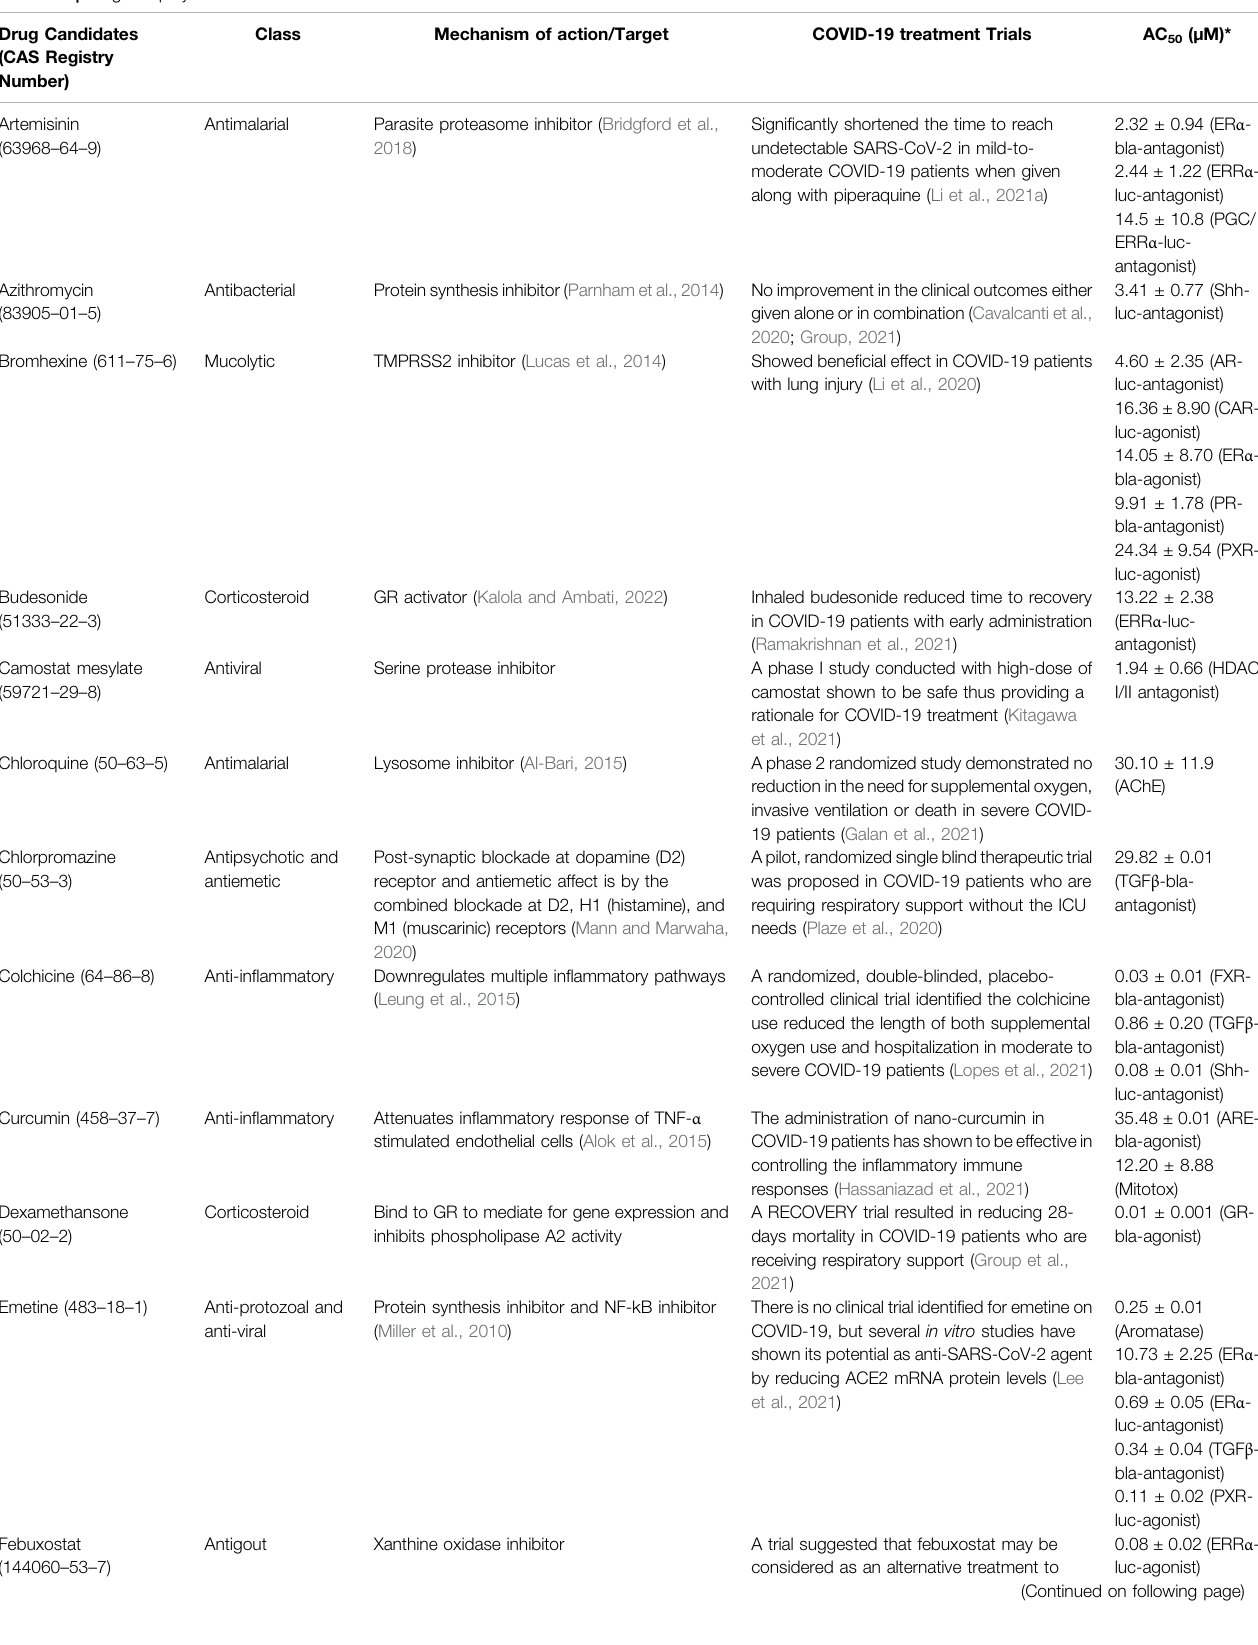
TABLE 1 | Drugs employed in the current treatment trials of